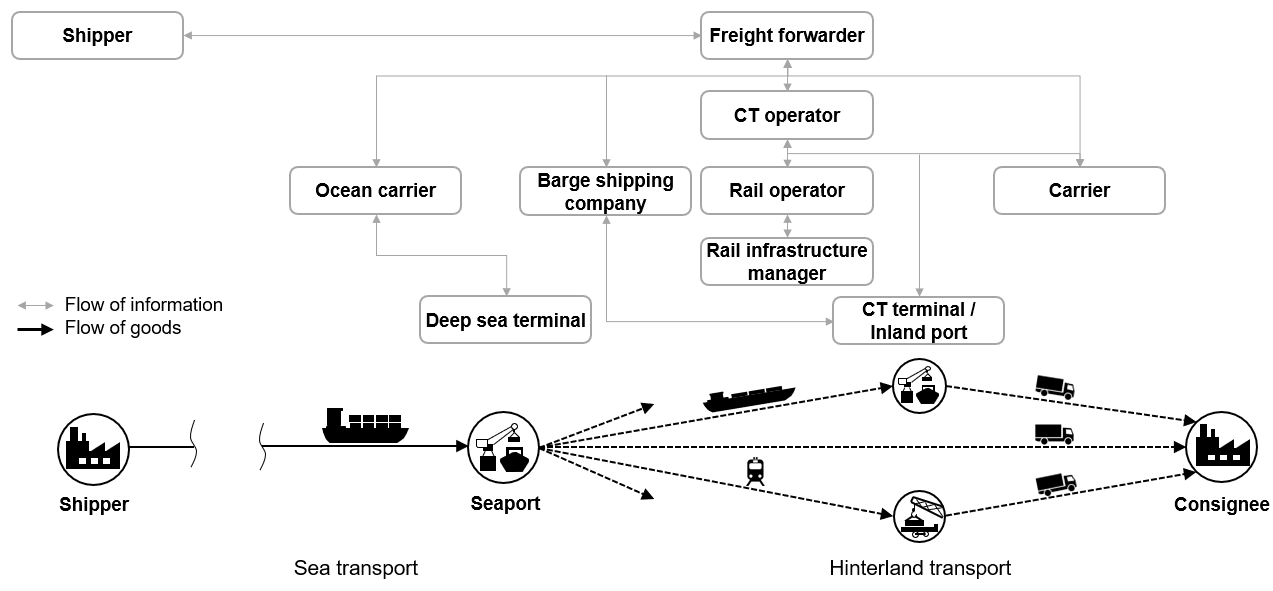
Figure 1. Exemplary flow of goods and information within a maritime transport